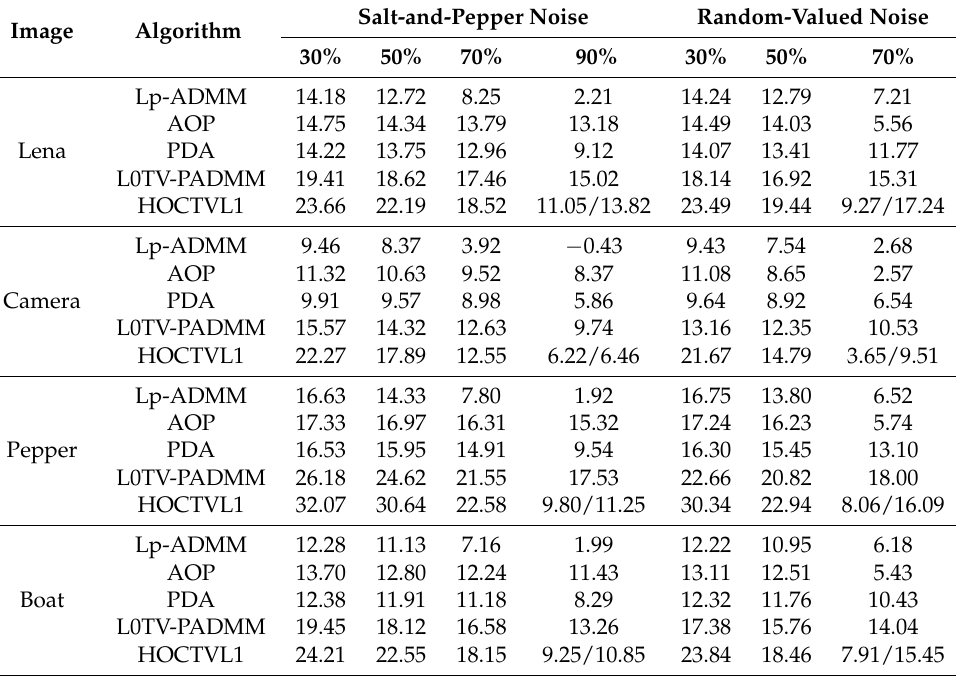
Table 3. SNR of five methods for test images corrupted by Gaussian blur and impulse noise.